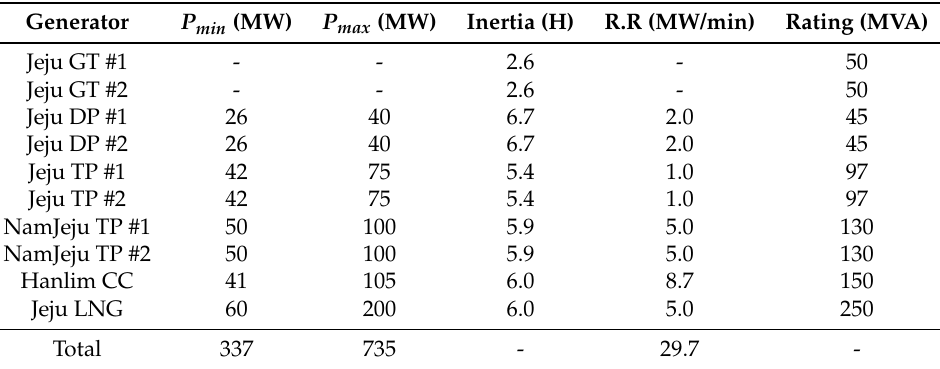
Table 1. Generators in the Jeju power system.